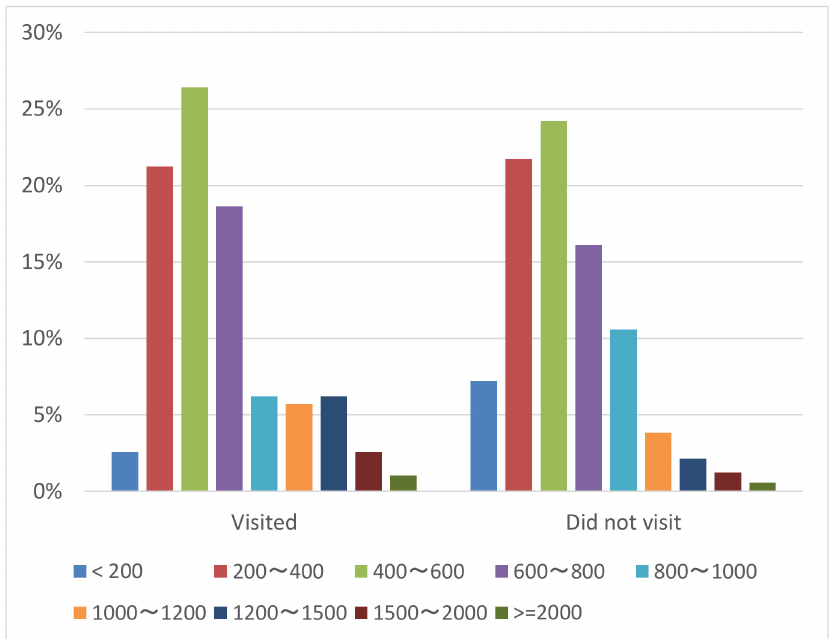
Figure 4. Ratios of respondents who visited and respondents who did not visit peri-urban forestlands and mountains by different household-income groups (Unit: million